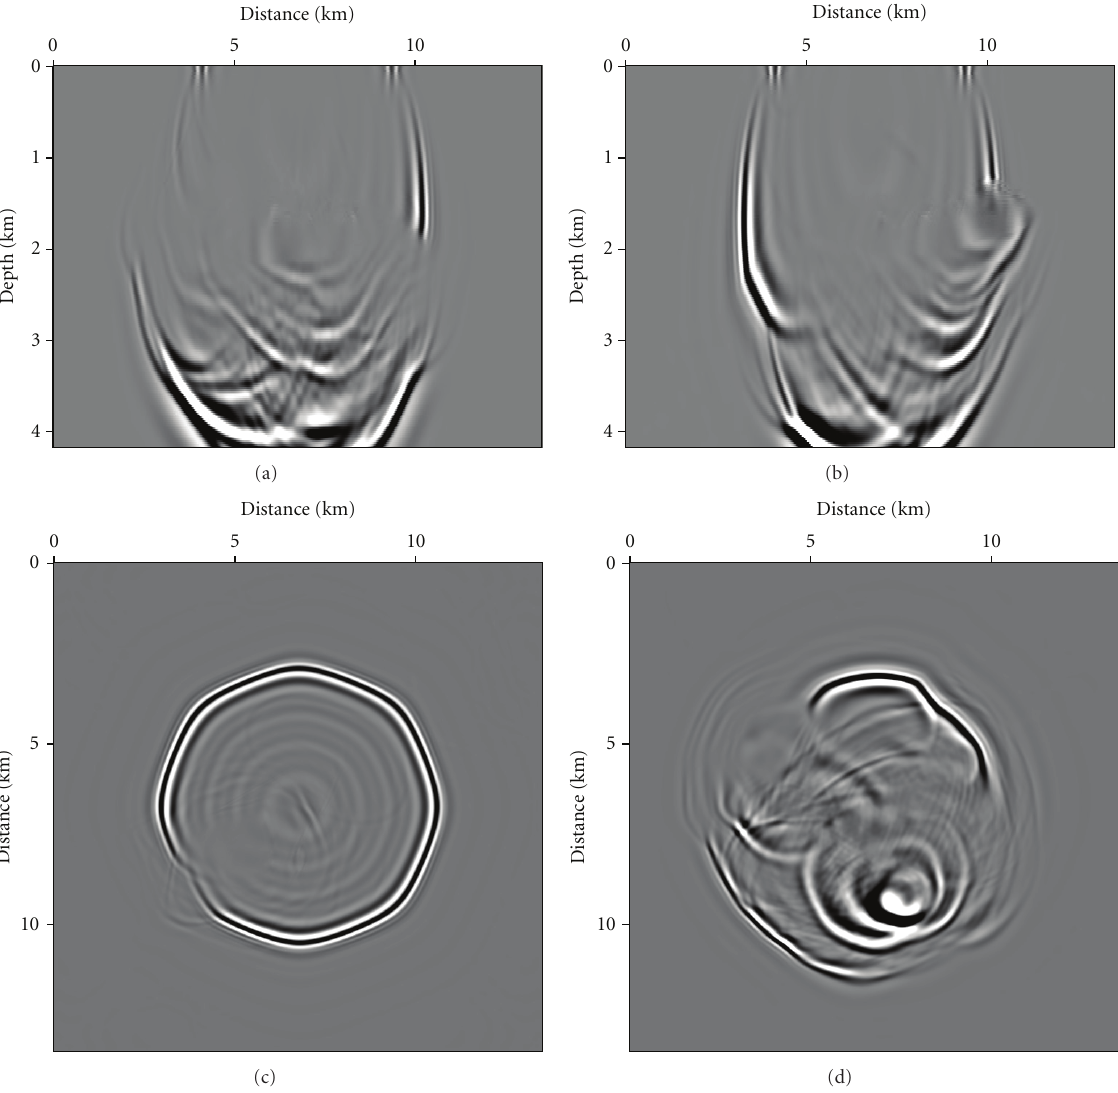
Figure 11: Impulse response obtained by FD migration using alternating four-way splitting and without Li correction (cross-sections as